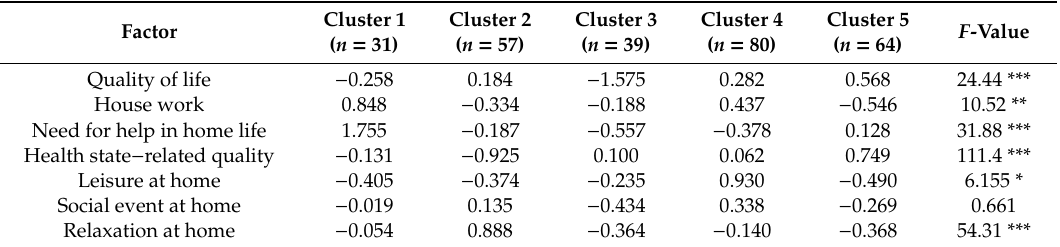
Table 2. Results of cluster analysis for residentially-based lifestyle of older